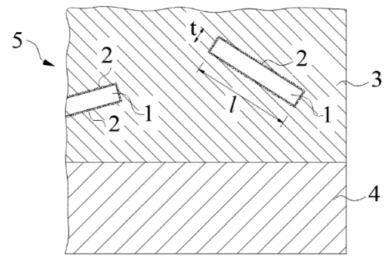
Figure 11. Electromagnetic wave-absorbing material acc. to patent. Designations: 1—fibers, 2—material with low loss factor, e.g., epoxy resin or neat resin, 3—resinous matrix, 4—protected surface, 5—composite coating (after